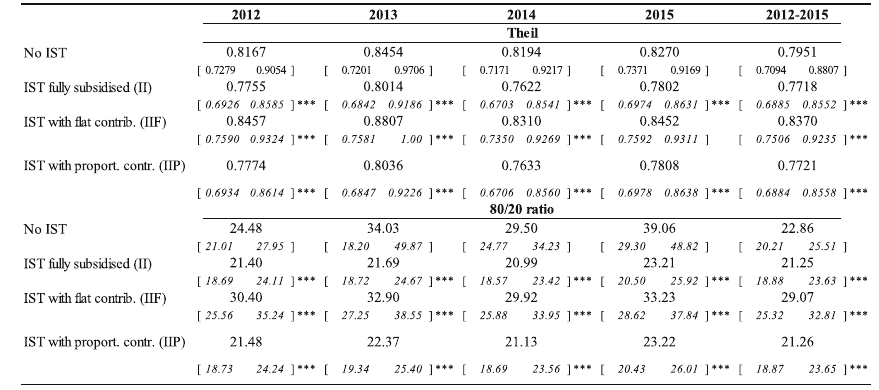
Table 7 Effects of the IST on farm income concentration. Theil and 80/20 ratio. Years from 2012 to 2015 and whole period